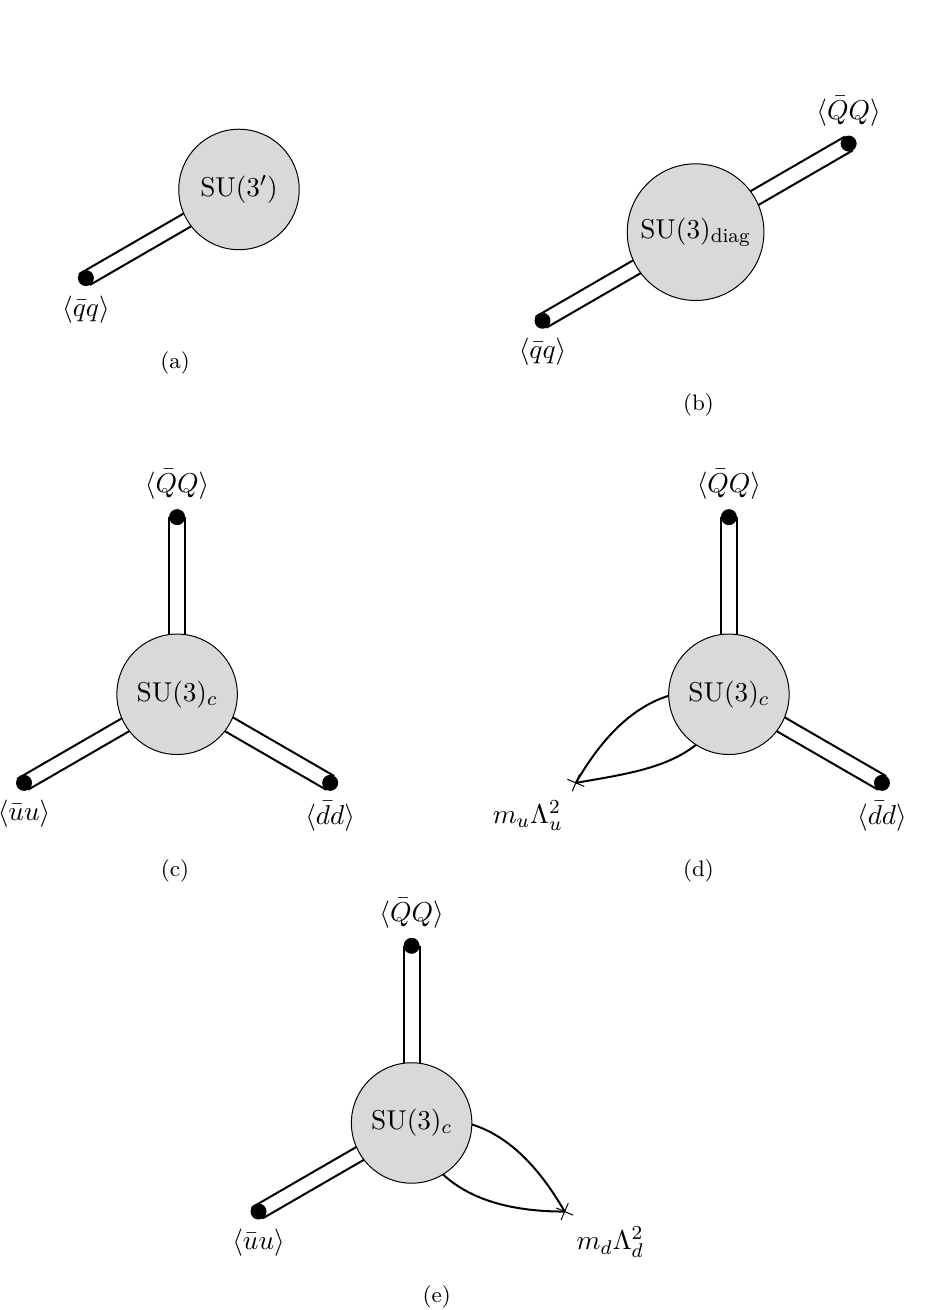
Figure 3 . Instanton diagrams for the M1 model variant of the color unification model from ref. [1], where Q and q are exotic quarks from table 1. We distinguish between instantons from different non-Abelian gauge groups, and quark bilinears are organized according to chirality flipping